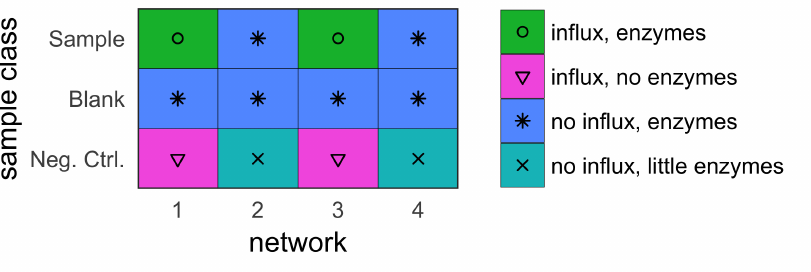
Figure 1. External tinderesting data, simulated setup.